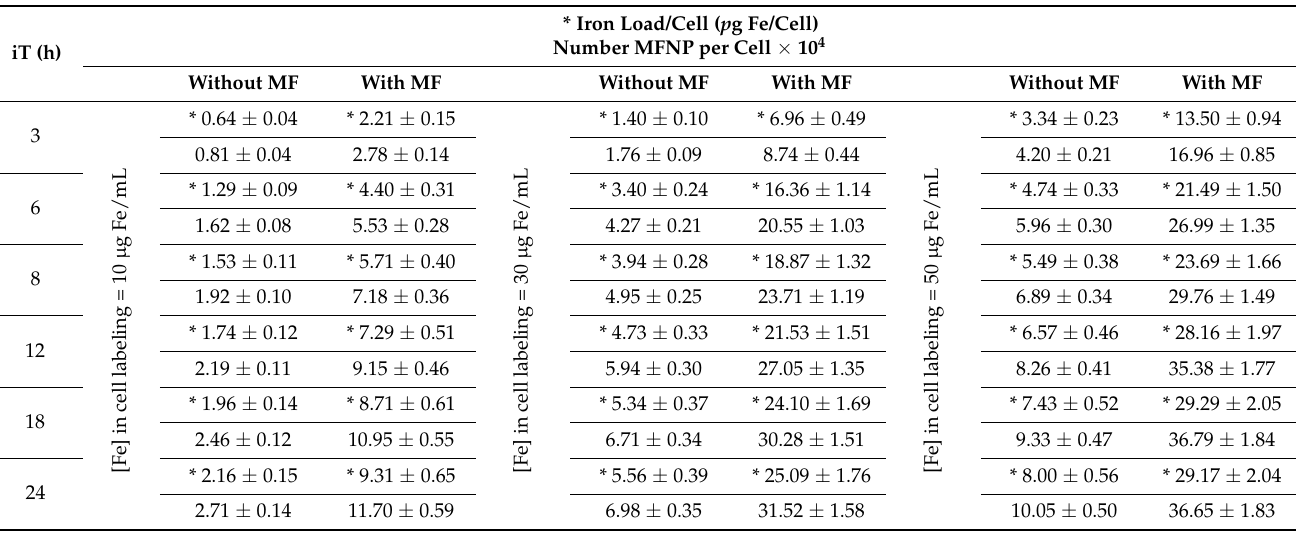
Table 3. The iron load quantification MFNP internalized into hBM-MSC by the ICP-MS signal intensity using different labeling